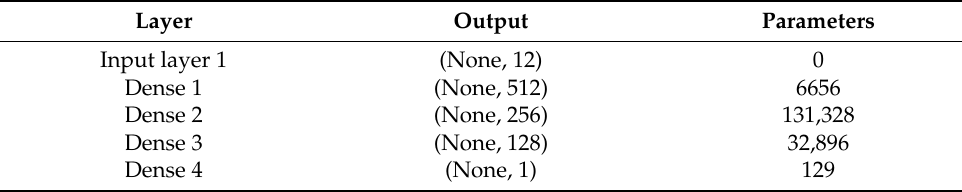
Table 6. CGAN and WCGAN models discriminator